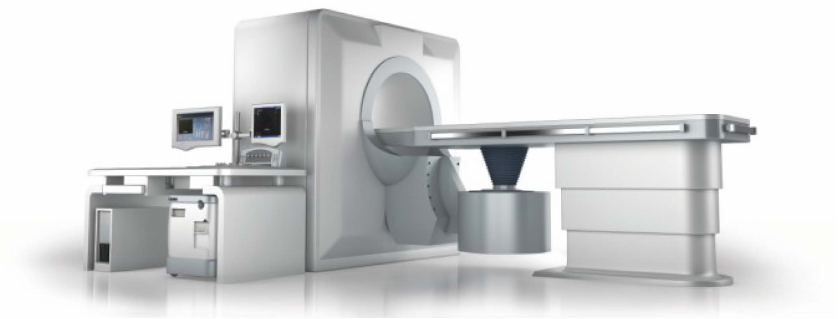
Figure 2. Haifu clinical HIFU